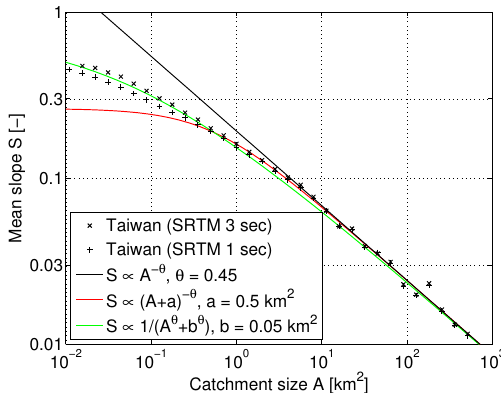
Figure 1. Relationship between mean channel slope and catchment size for the topography of Taiwan. Channel slopes and catchment sizes were derived from the SRTM1 and SRTM3 DEMs, and mean slopes were obtained from logarithmic bins with a factor of (black